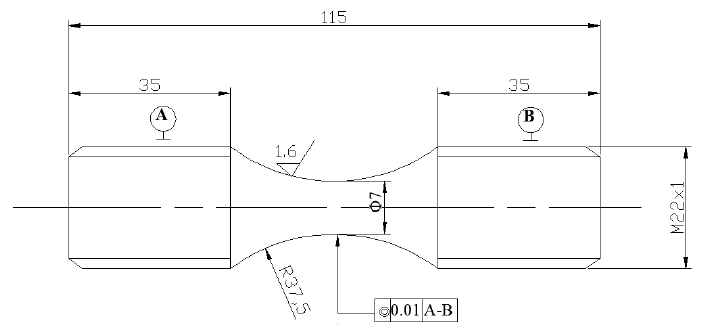
Figure 2. Geometry of the fatigue test specimen (units: mm).